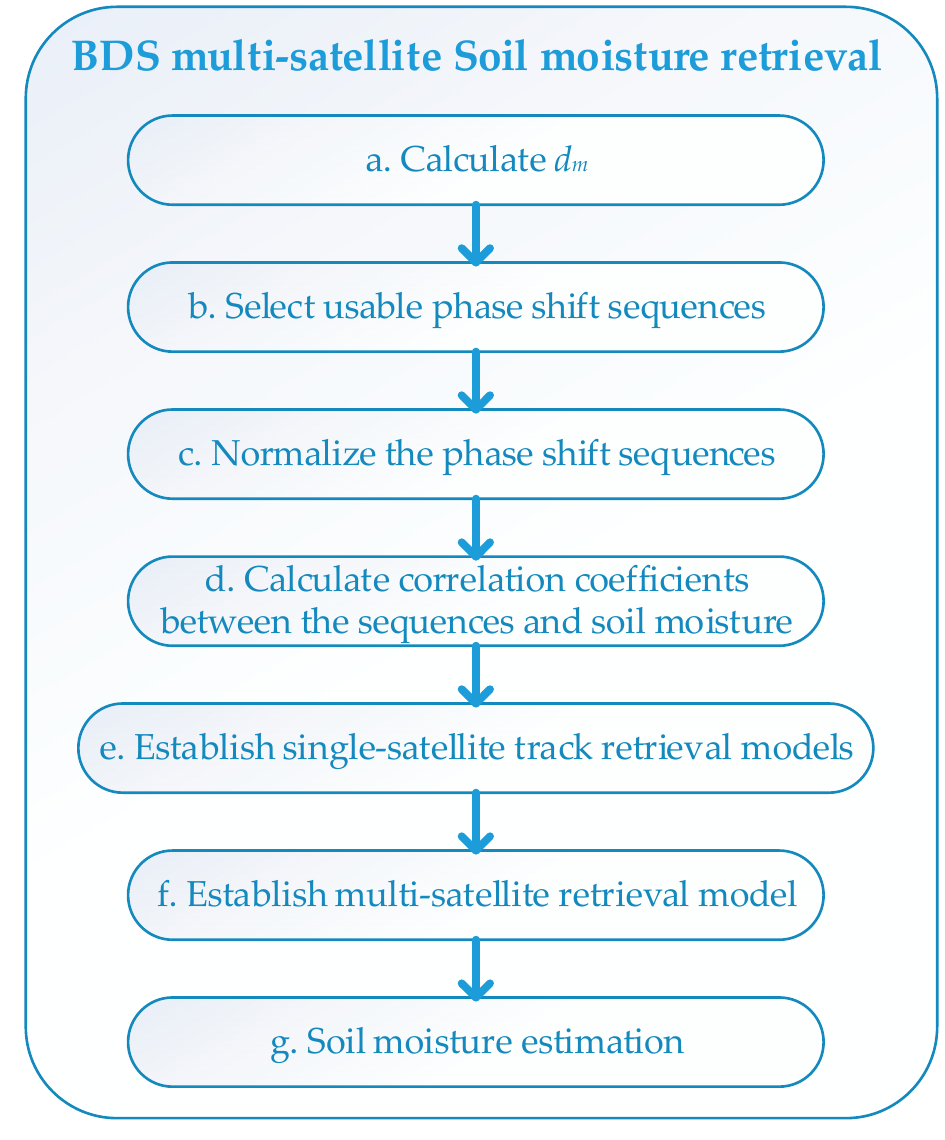
Figure 3. Flowchart depicting the steps of BDS multi-satellite soil moisture retrieval.